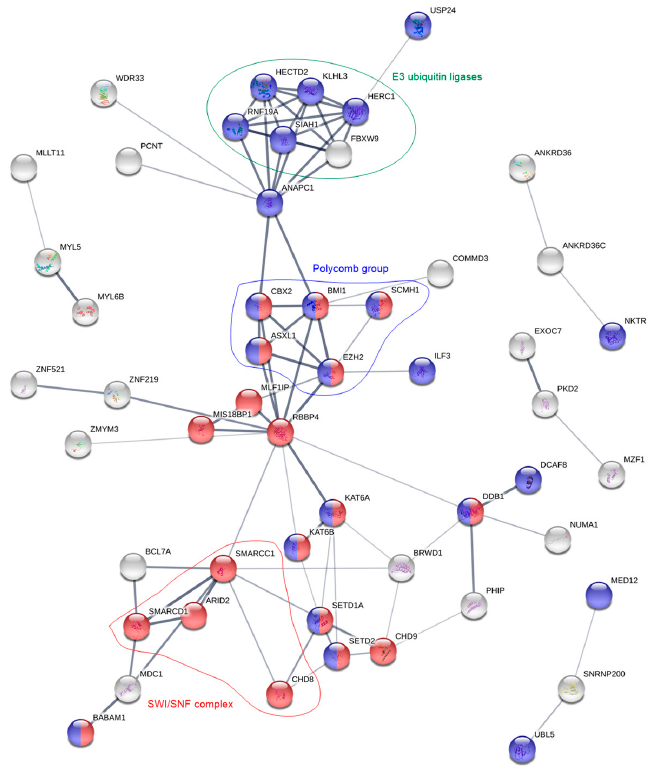
Figure 4. Protein network analysis of the overexpressed genes in the TLR non-responsive patient cells. For clarity, the figure only contains proteins that are interrelated with at least two other proteins. Red and blue color correspond to the GO-terms “chromatin modification” and “cellular protein modification process”, respectively. Groups of proteins with identical functions (E3 ubiquitin ligases, green) or that are part of the same protein complexes (polycomb, blue; SWI/SNF, red) are highlighted.